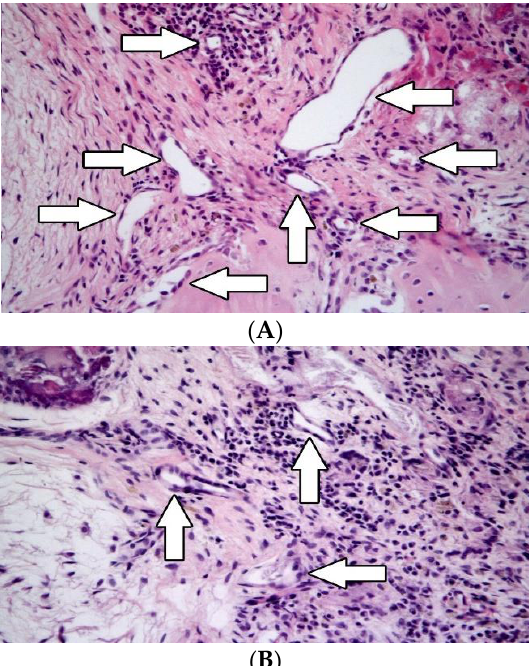
Figure 3. Angiogenesis was assessed by counting lumina of newly formed small blood vessels (white arrows). It was higher in group A (without application of CsA; ( A )) compared with group B (with application of CsA; ( B )). Hematoxylin-eosin, original magnification